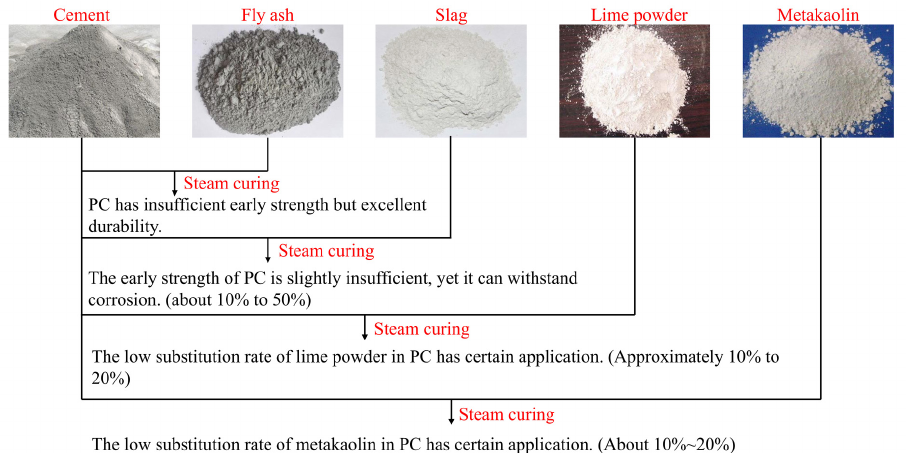
Figure 6. The application of mineral